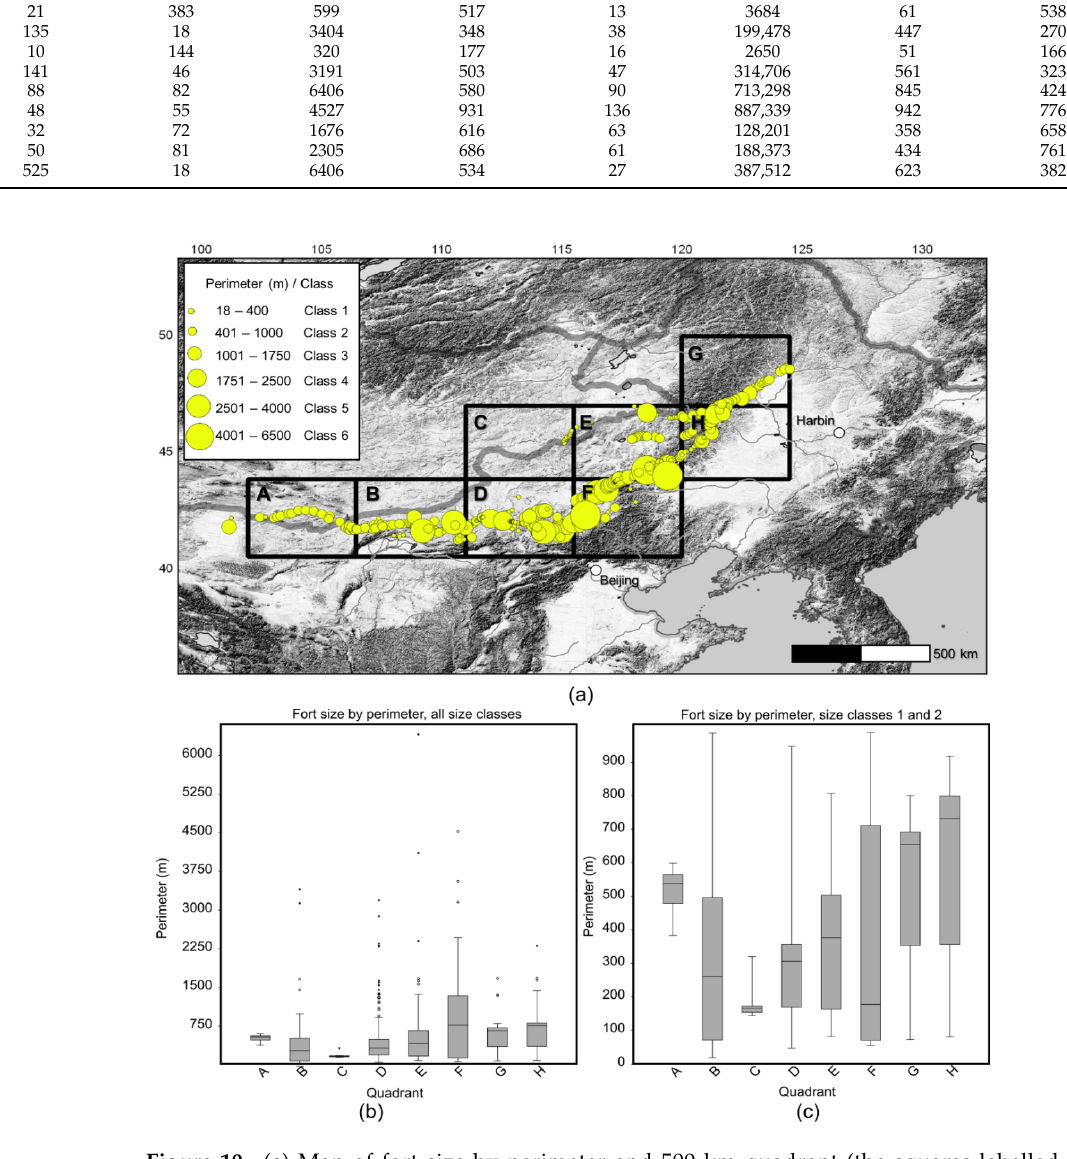
Figure 10. ( a ) Map of fort size by perimeter and 500 km quadrant (the squares labelled A–H), ( b ) box plot of all fort size classes by perimeter (m) and 500 km quadrant (A–H) and ( c ) box plot of fort classes 1 and 2 by perimeter (m) and quadrant (A–H). All the data necessary to replicate these fig- ures are included within the Supplemental Material.